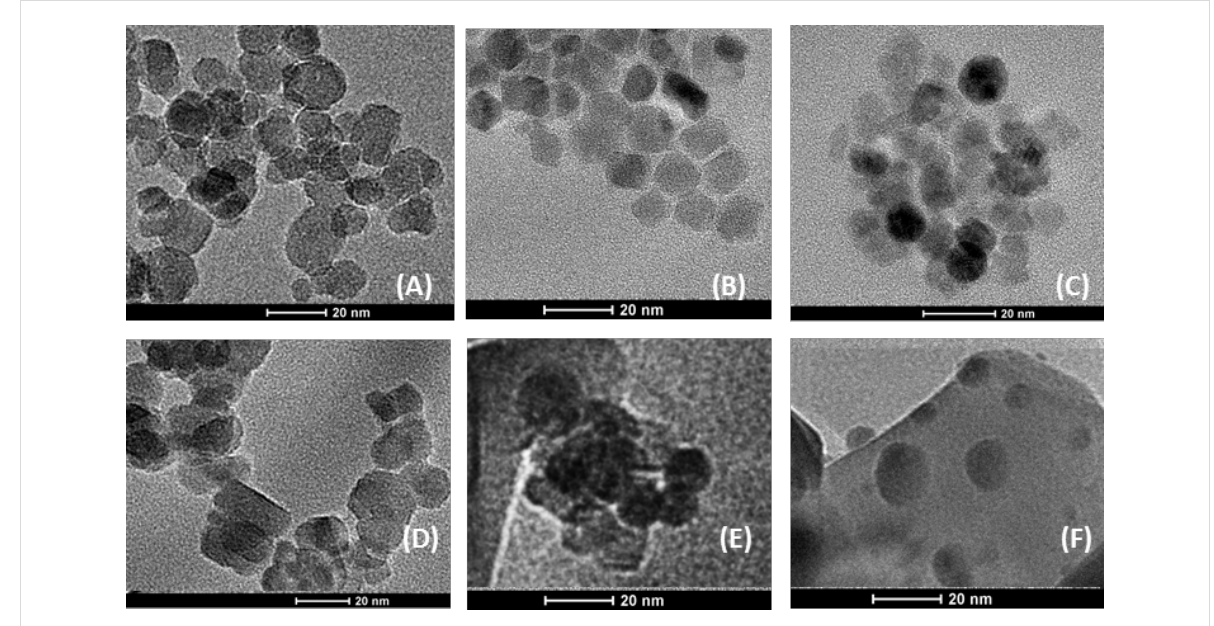
Figure 2: TEM images of magnetite nanoparticles before (as-prepared) (A, B, C) and after the heating process at 500 °C ( D, E, F), for MNP-1, MNP-2, and MNP-3, respectively.